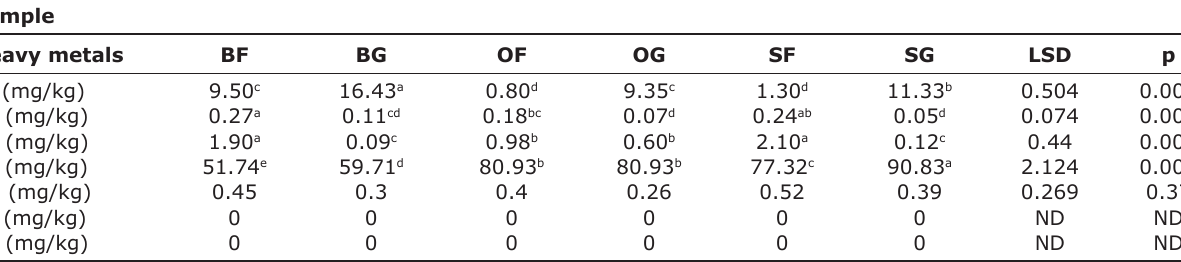
Table-1: Concentration of selected heavy metals in the fresh and grilled beef samples. Sample Heavy